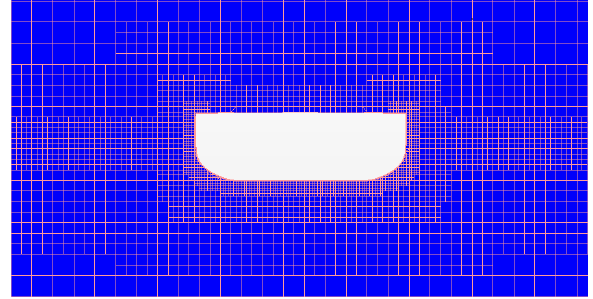
Figure 7. Hexahedral trimmed mesh.